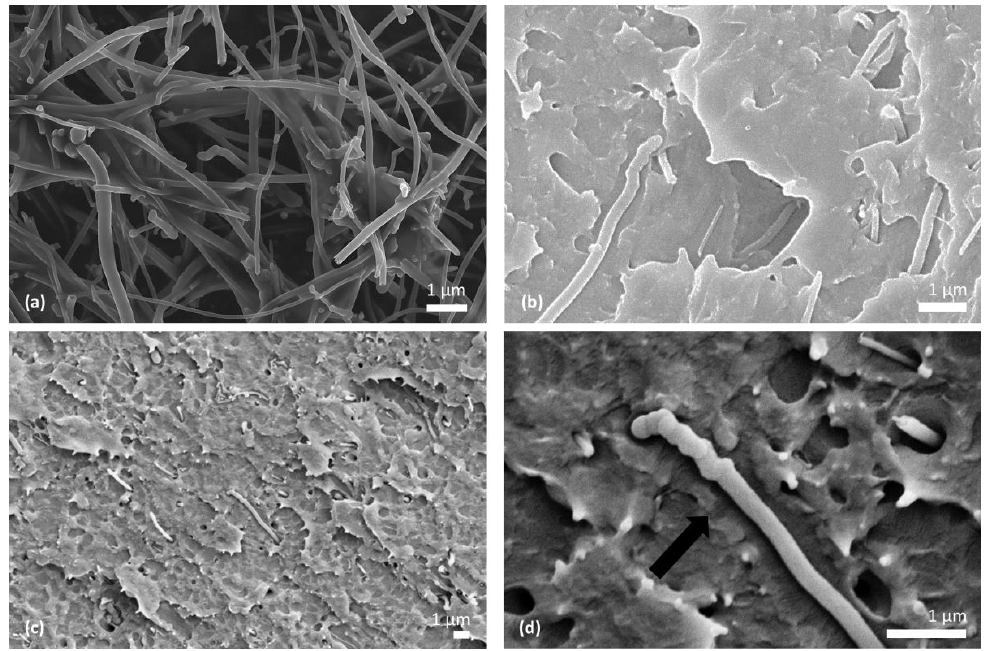
Figure 3. SEM micrographs showing the morphology of ( a ) as received CNF; ( b ) 2CNF-PEEK; ( c ) 5CNF-PEEK at low magnification; ( d ) 5CNF-PEEK at high magnification via SEM.